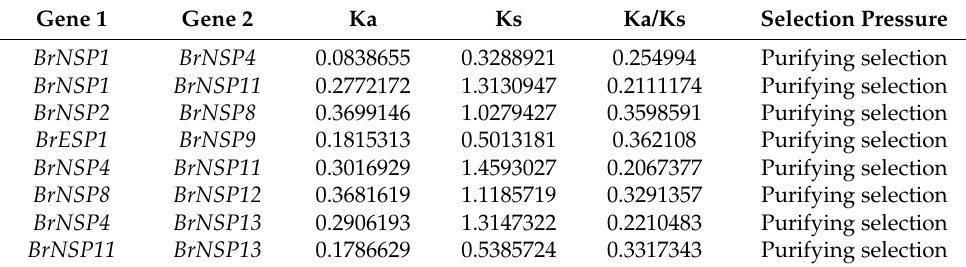
Table 2. Duplications of ESP and NSP genes in Chinese